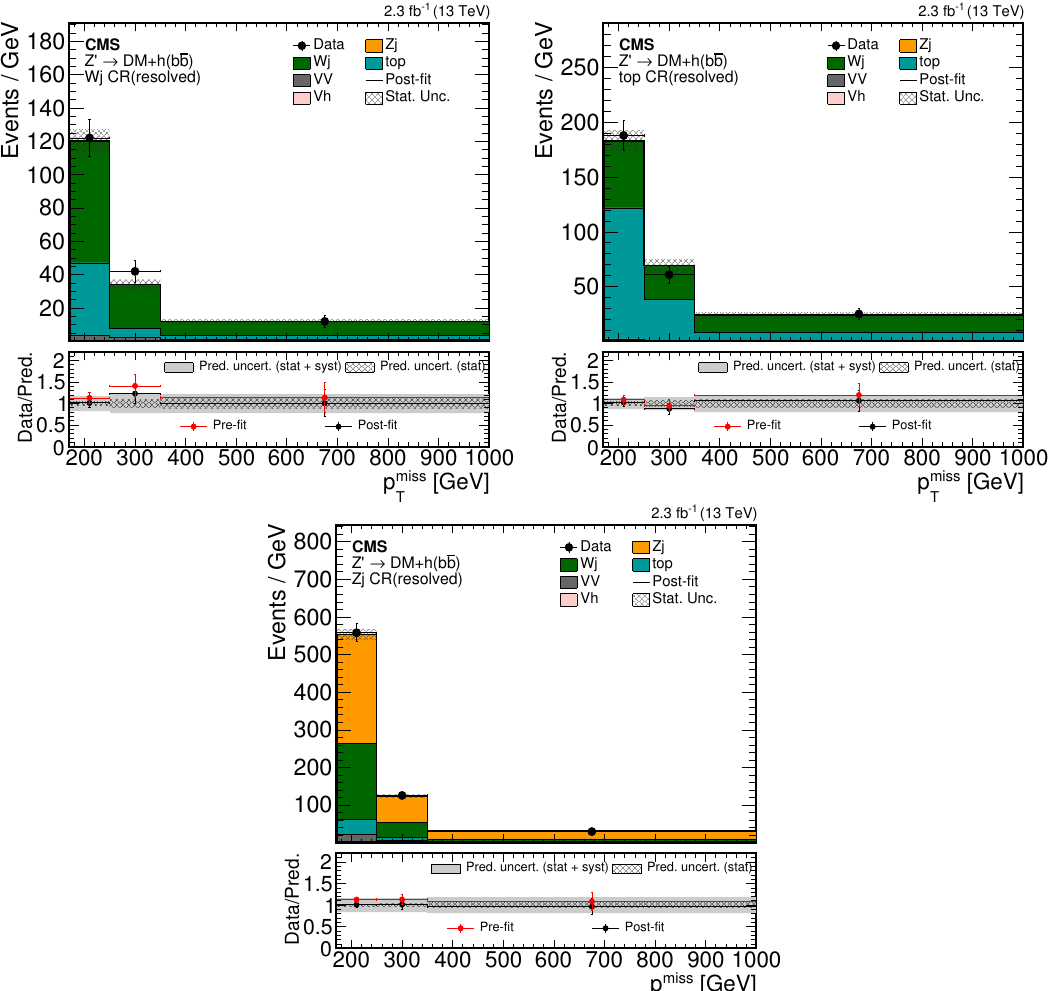
Figure 4 . Post-(cid:12)t distribution of p miss expected from SM backgrounds and observed in data for the T W+jets (upper left), top quark (upper right) and Z( ! (cid:23)(cid:23) )+jets (lower) CRs for the resolved regime. The bottom panels show the data-to-simulation ratios for pre-(cid:12)t (red markers) and post-(cid:12)t (black markers) background predictions with a hatched band corresponding to the uncertainty due to the (cid:12)nite size of simulated samples and a gray band that represents the systematic uncertainty in the post-(cid:12)t background prediction (see section 6). The last bin includes all events with p miss > 350 GeV. T